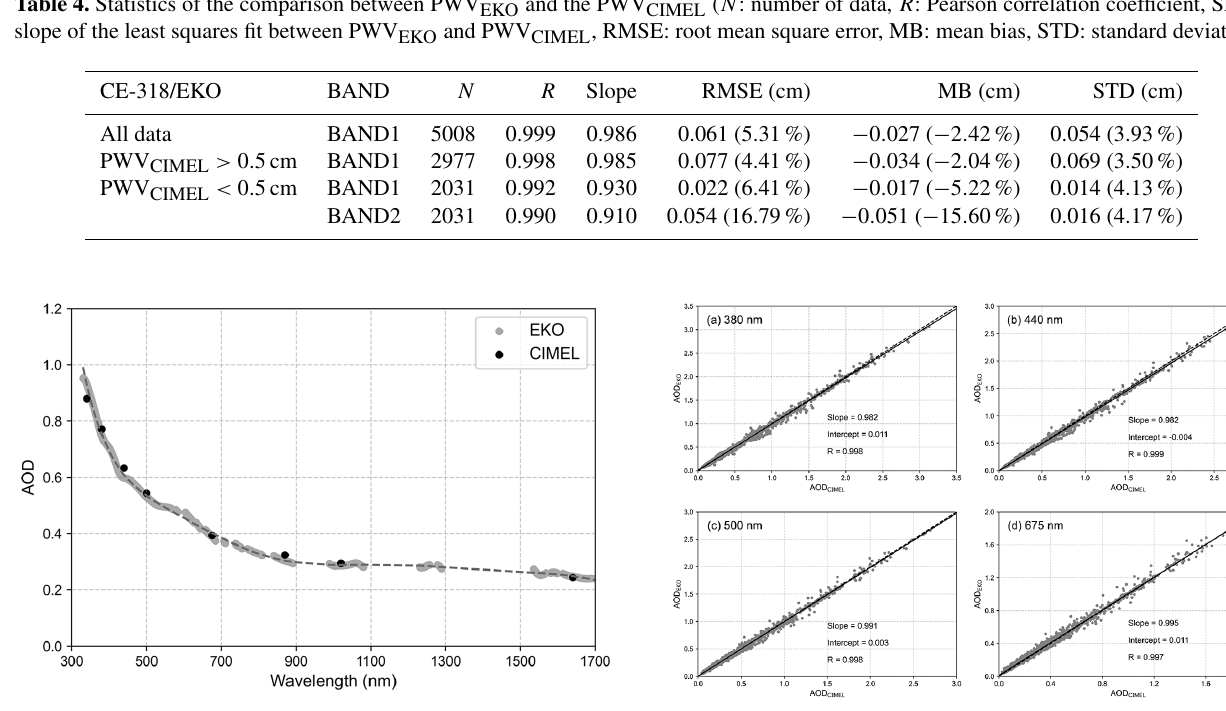
Figure 12. The AOD was retrieved from EKO and CE-318 on 6 June 2020 (15:22UTC + 8), the dashed line is the spectral AOD obtained by the AOD EKO high-order fitting.